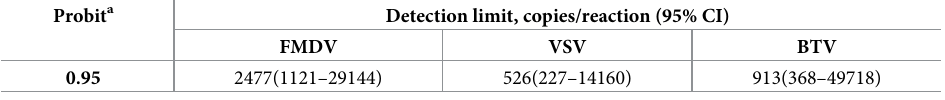
Table 3. Probit analysis to determine the detection limit of mLAMP.